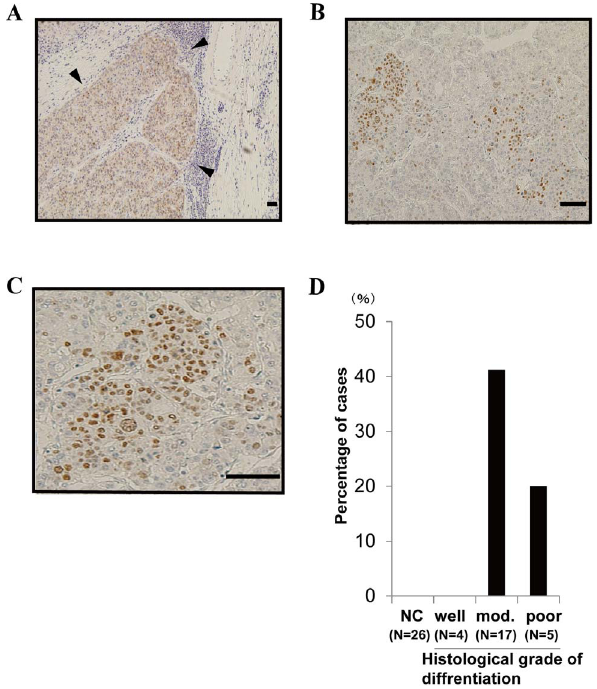
Figure 3. Wee1 kinase is expressed in moderately to poorly differentiated HCC. A-C, Wee1 kinase was stained with anti-Wee1 antibodies in surgically resected HCC samples ( . HCC lesion). Anti- Wee1 antibody staining revealed mostly nuclear localization in Wee1 kinase-positive cells. The magnification is 40 x (A), 100 x (B), or 200 x (C). Scale bars =200 m m. D, Wee1 kinase is expressed in moderately to poorly differentiated HCC. A chi-square test revealed significant differences (p=0.0026). (NC; Non-cancerous lesion, Mod.;